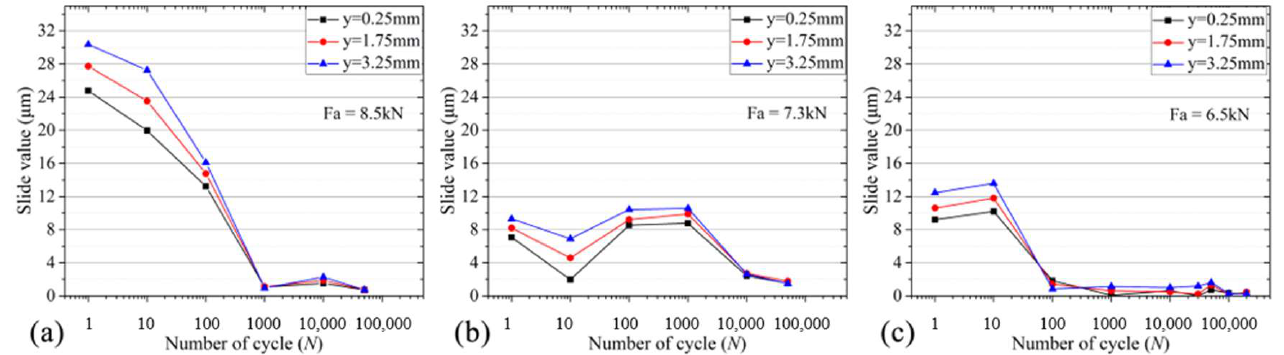
Figure 11. The evolution of relative slip with the cycle number during the test for the ( a ) 8.5 kN, ( b ) 7.3 kN, and ( c ) 6.5 kN cases.